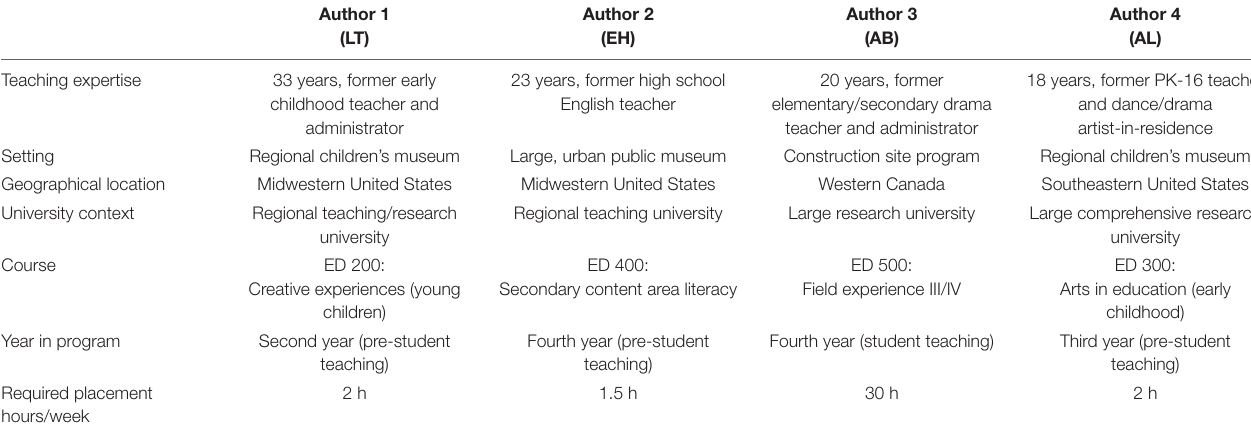
TABLE 2 | Teacher educator participant information.